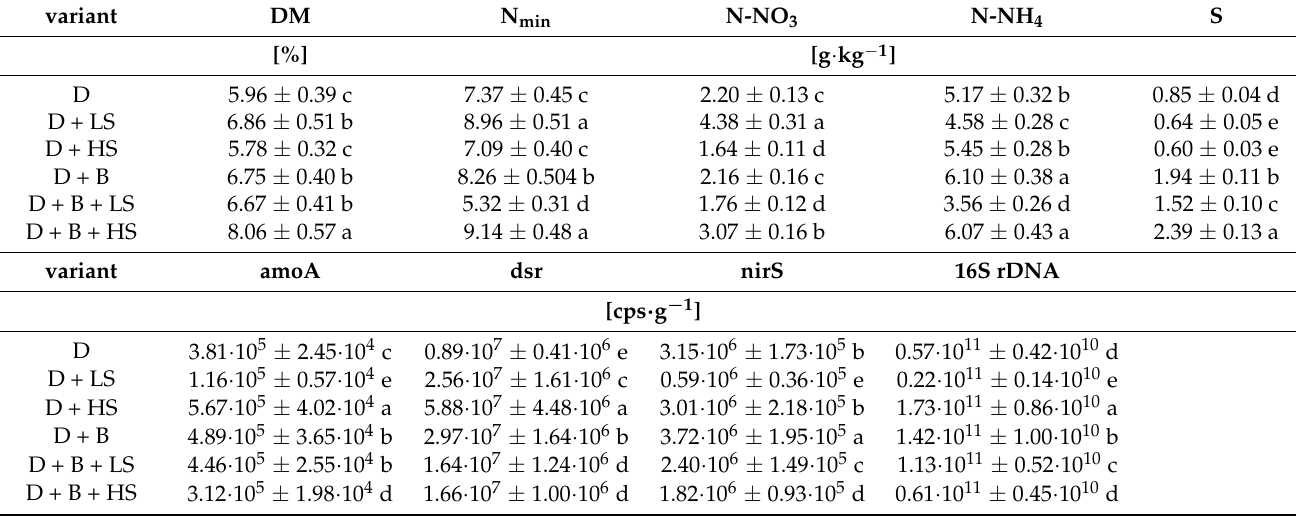
Table 3. Properties of matured digestate expressed in fresh